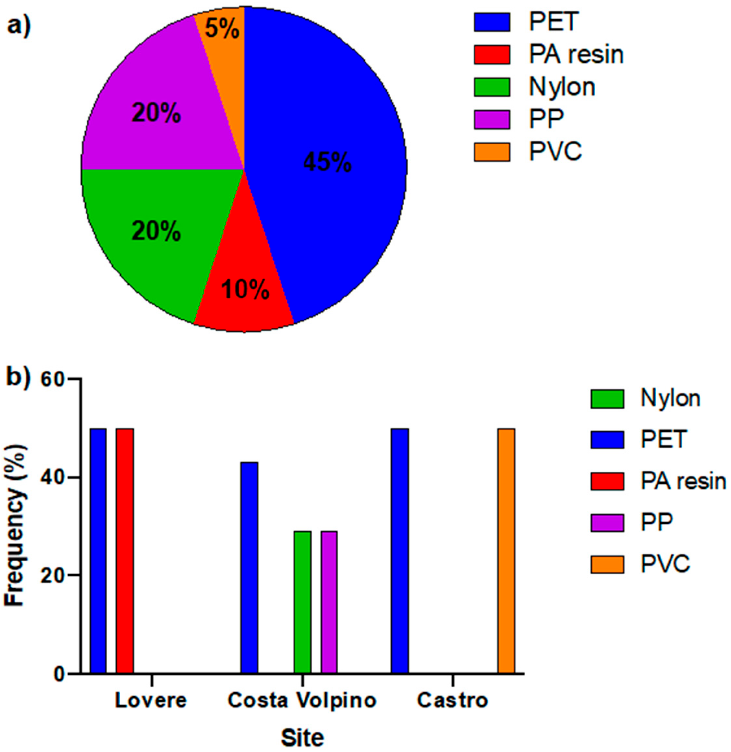
Figure 3. ( a ) Chemical composition (% frequency) of total microplastics (n = 20) in samples from Lake Iseo; ( b ) Frequency (in percentage) of each chemical compound (nylon, polyethylene terephthalate—PET, polyamide resin, polypropylene—PP, polyvinyl chloride—PVC) in the samples from the three sites.